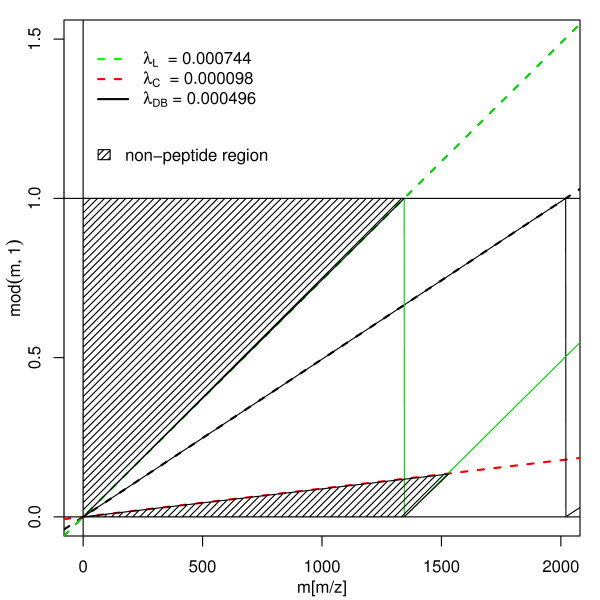
Schema of non-peptide mass filtering. Abscissae – peptide mass, ordinate – m mod 1, dashed region – non-peptide masses. Green line – decimal part of poly-(L(lys), I(ile)) peptide masses as a function of their mass. Red line – decimal part of poly-(C(cys)) peptide masses as function of their mass. Black line – Predicted cluster centres using the Equation 2.